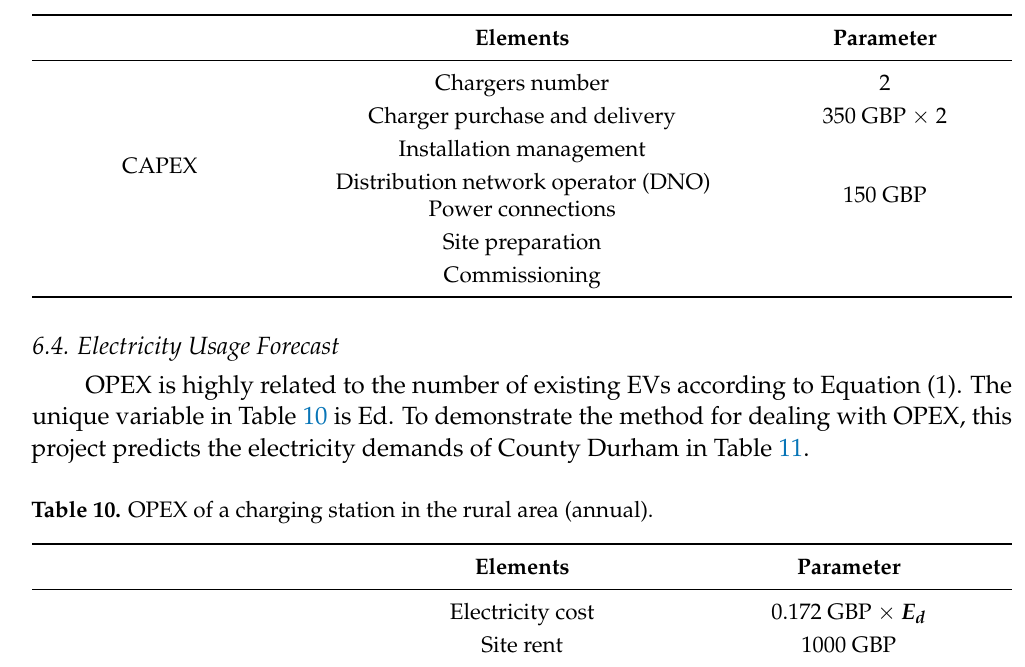
Table 9. CAPEX of a charging station in the rural area.